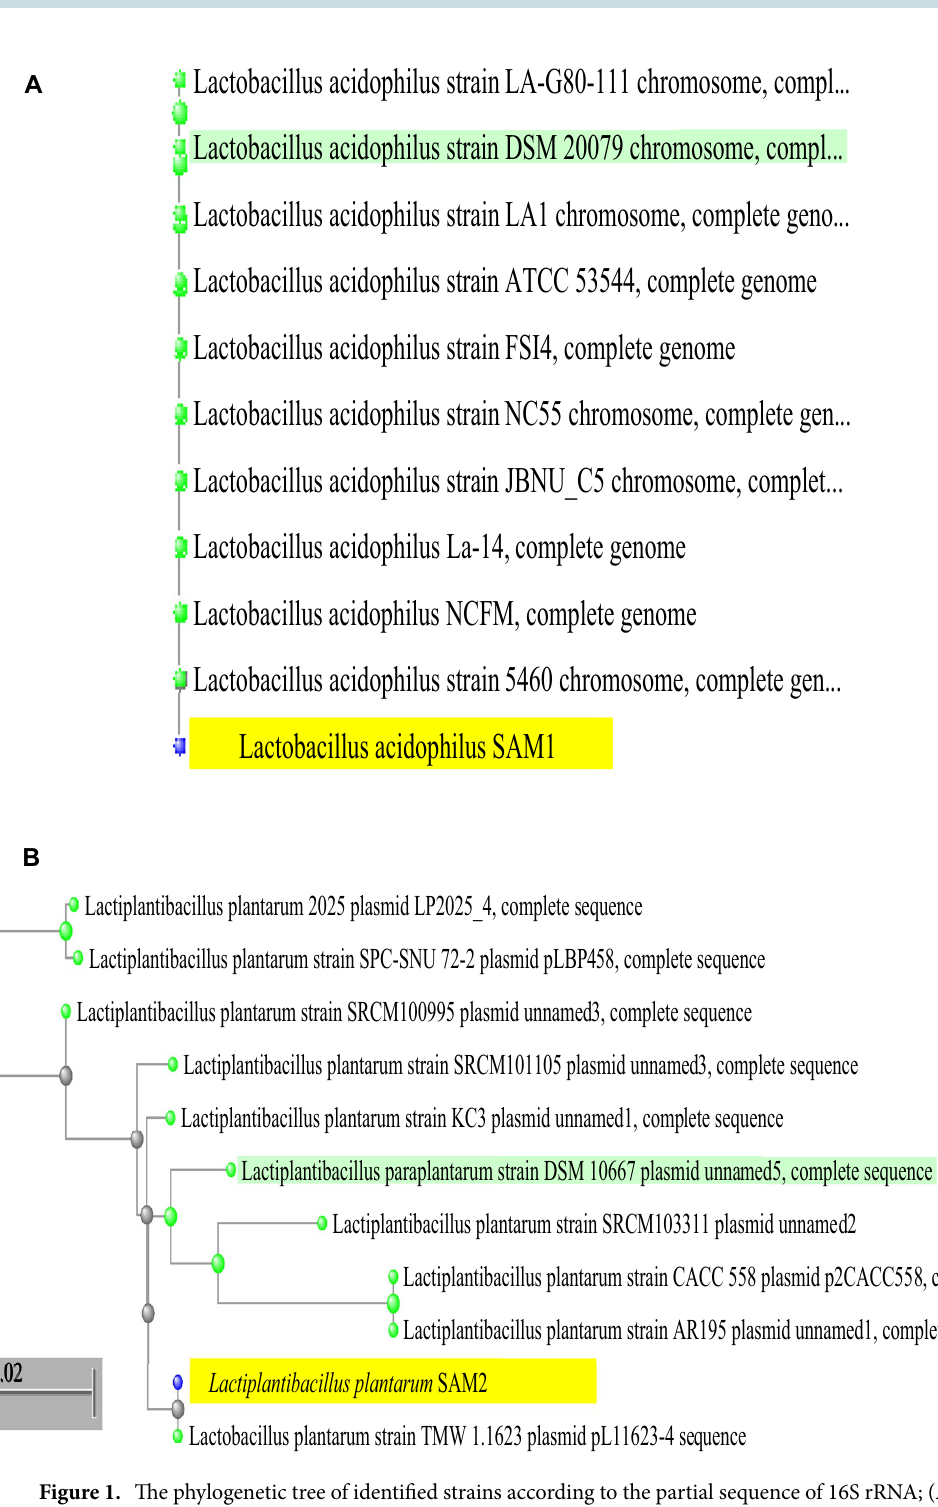
Figure 1. The phylogenetic tree of identified strains according to the partial sequence of 16S rRNA; ( A ) Lactobacillus acidophilus SAM1, ( B ) Lactiplantibacillus plantarum